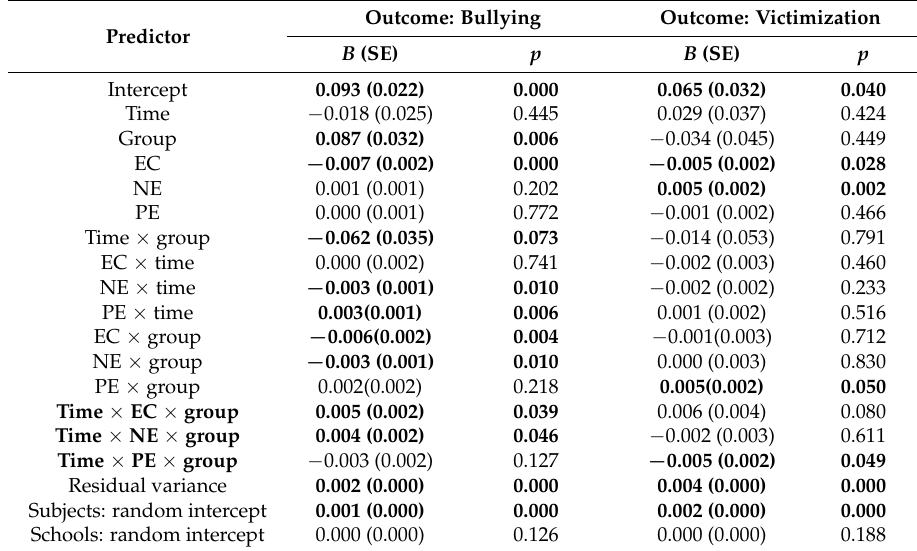
Table 2. Mixed model predicting the moderating role of effortful control (EC), negative emotionality (NE), and positive emotionality (PE) on bullying and victimization outcomes.